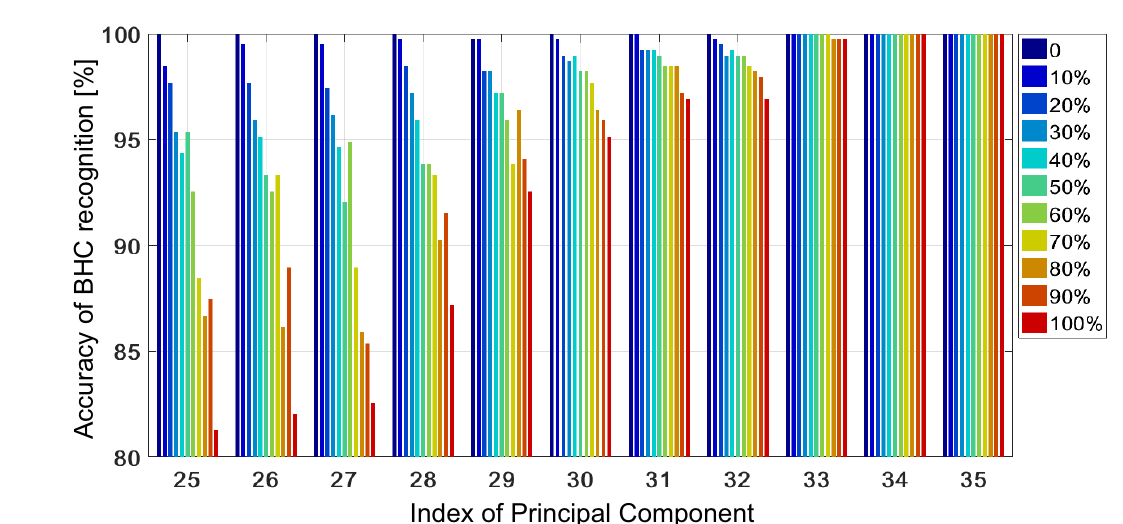
Figure 8. Accuracy of BHC recognition obtained with adaptive KSVM versus the number of PCs (from 25 to 35) at various contributions of outer-class samples in the test